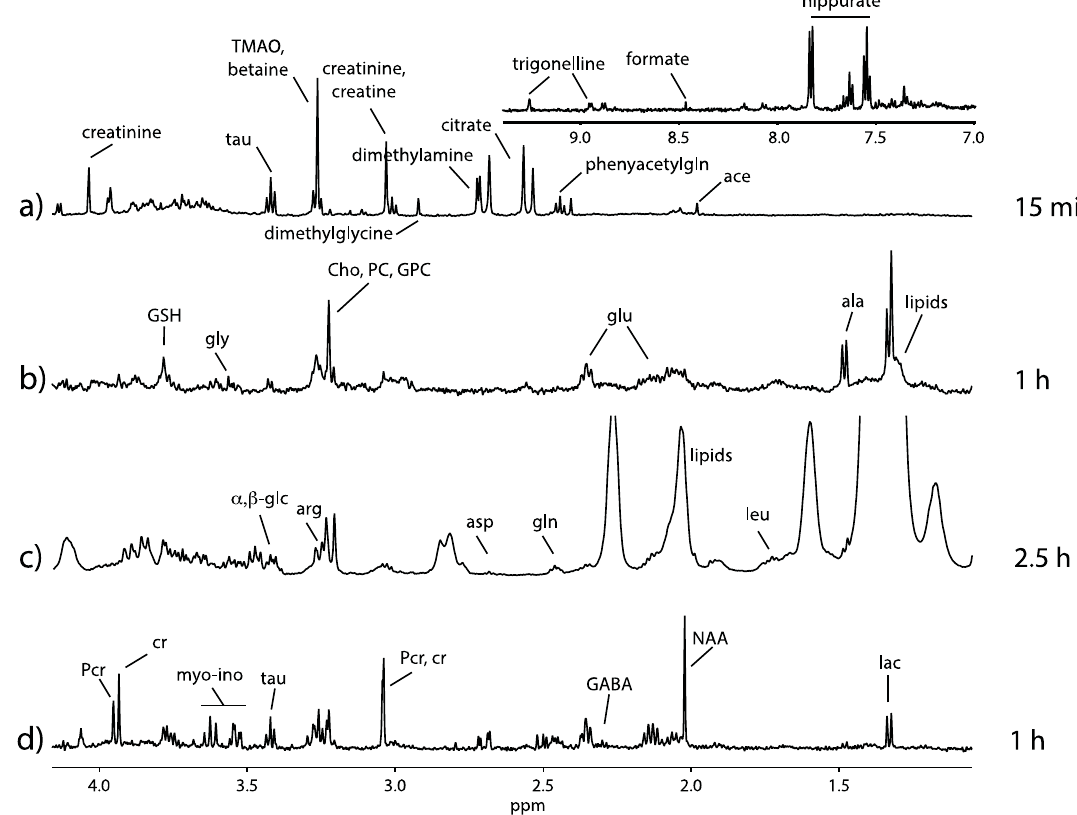
Figure 3. 1 H HR- μ MAS nuclear magnetic resonance (NMR) spectra spinning at 4 kHz from ( a ) rat urine in PBS/D 2 O prepared with automatic pipette, ( b ) 400 nL K562 cell suspension in PBS/D 2 O buffer (pH = 7.4) prepared with a 3D-printed funnel, ( c ) 400 nL of C. elegans ( n = 30) suspension in D 2 disposable 0.5 mm biopsy punch. Total acquisition times are indicated for each spectrum. Spectra ( b ) and ( d ) were acquired using the Carr-Purcell-Meiboom-Gill (CPMG) pulse sequence (d20 = 0.2 ms, loop = 200), and spectra ( a ) and ( c ) were acquired using the NOESY pulse sequence (mixing time 0.1 s). The main metabolic signatures are identified on the spectra. The preparation for each specimen is detailed in the Supplementary Protocol 1.